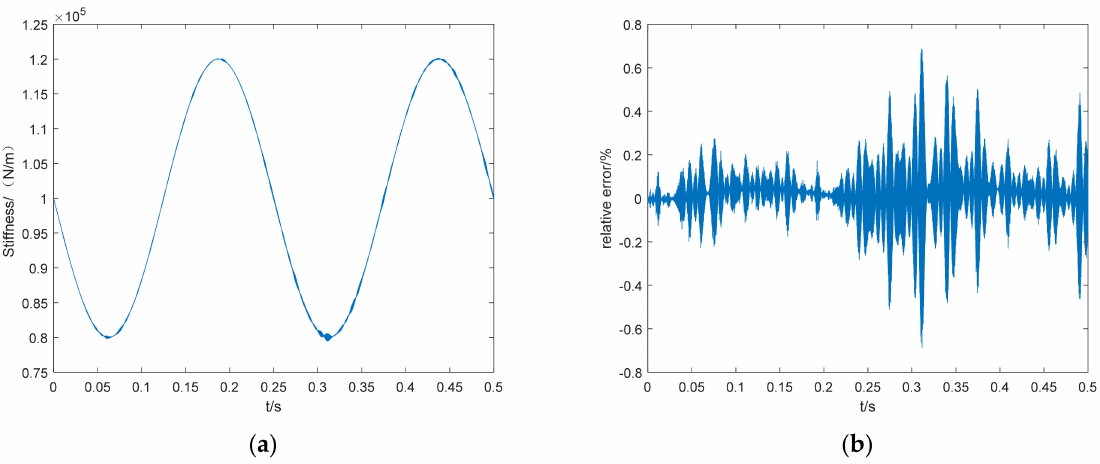
Figure 10. Time domain identification result ( a ) and relative error ( b ) of time-varying stiffness (cid:101) p 3 at 80 dB signal-to-noise ratio.